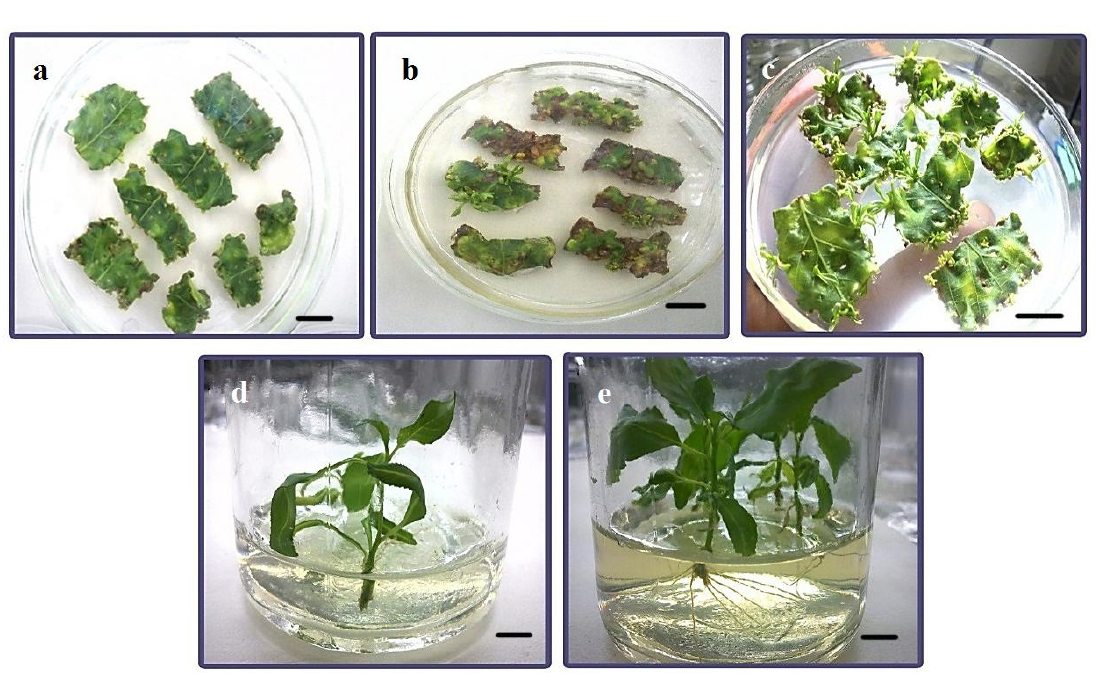
Figure 2. ( a ) Cocultivation of poplar leaf discs with Agrobacterium on MS medium; ( b ) Regenerated putative poplar transformants on MS selection medium that were generated without the optimization of transformation efficiency; ( c ) Regenerated putative poplar transformants on MS selection medium generated with the optimization of transformation